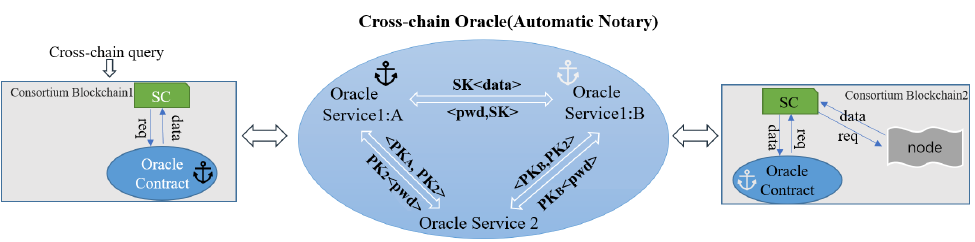
Figure 6. Mixed encryption for off-chain